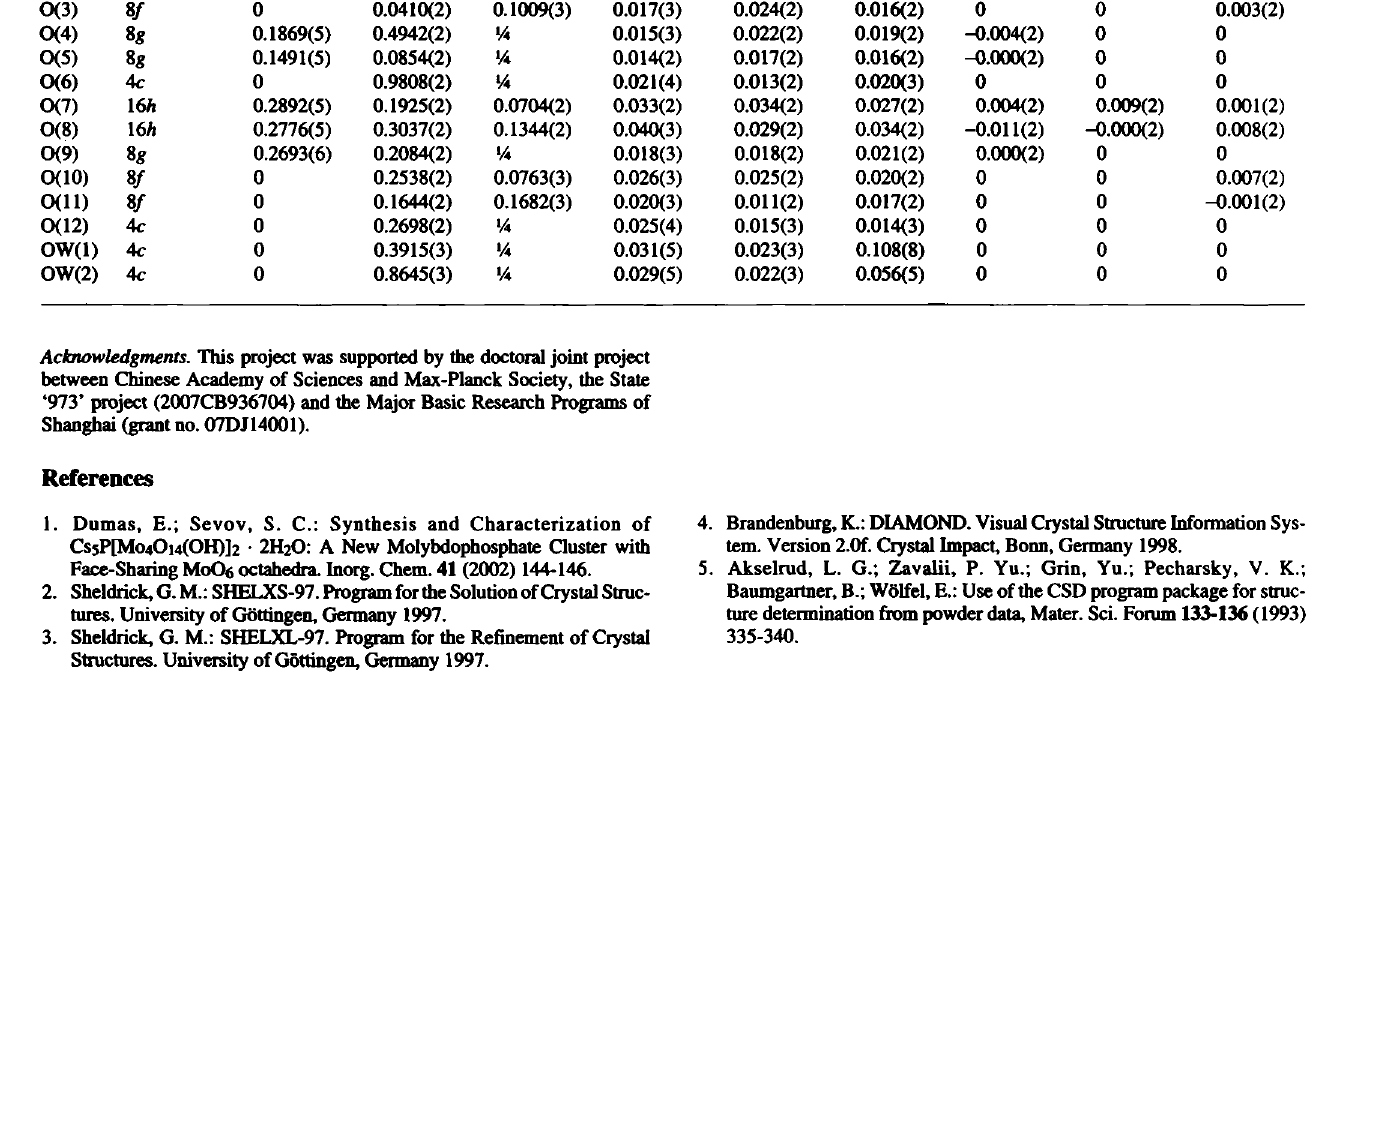
Table 2. Atomic coordinates and displacement parameters (in Â 2